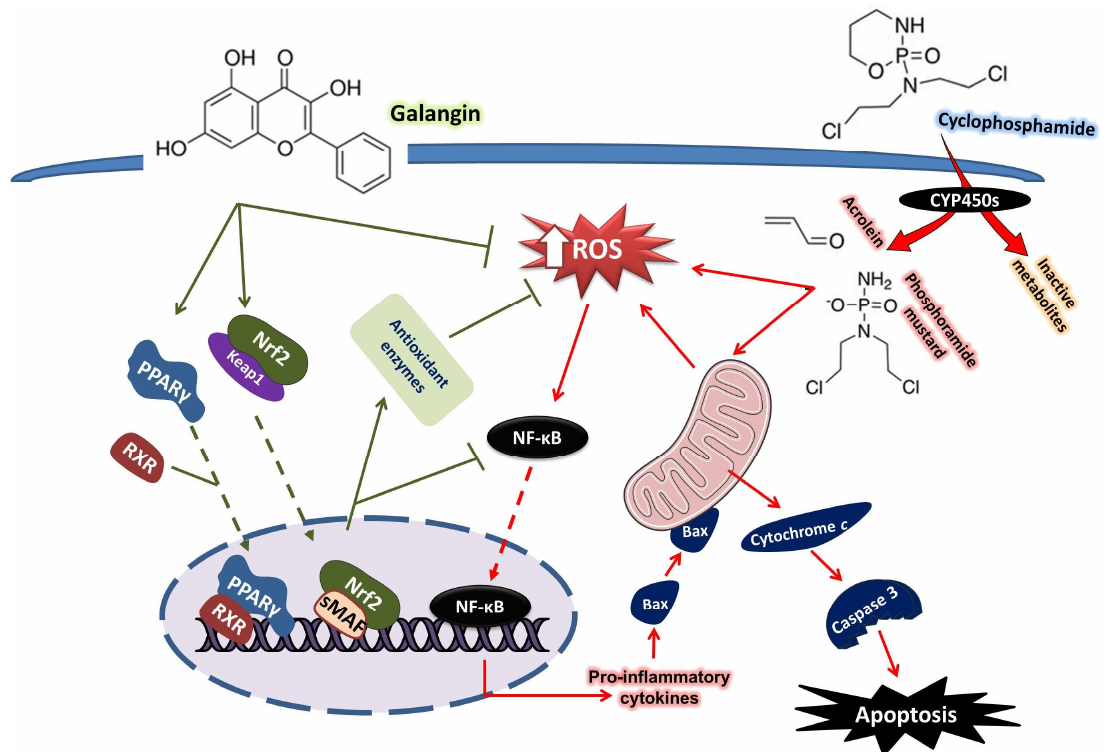
Figure 10. A schematic diagram illustrating the protective effect of galangin against cyclophosphamide hepatotoxicity. Galangin up-regulated Nrf2/HO-1 signaling and PPARγ, enhanced antioxidants, and suppressed ROS production, inflammation, and apoptosis in CP-induced rats. RXR, retinoid X receptor; CYP450, cytochrome P450; sMAF, small MAF proteins.